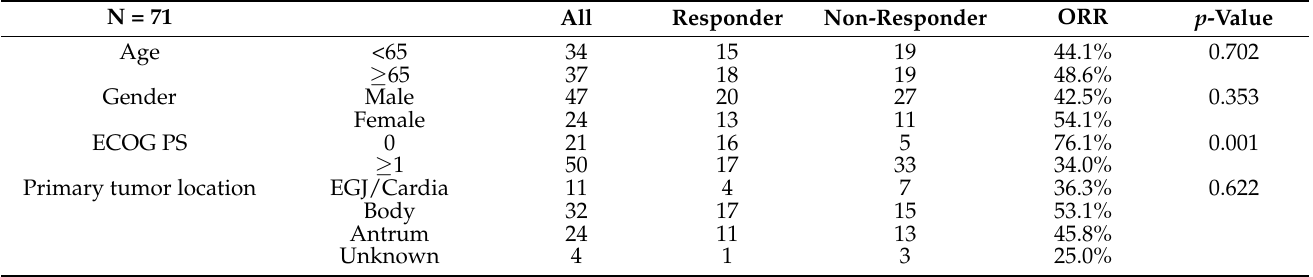
Table 1. Clinicopathological characteristics associated with response to anti-PD-1 therapy in